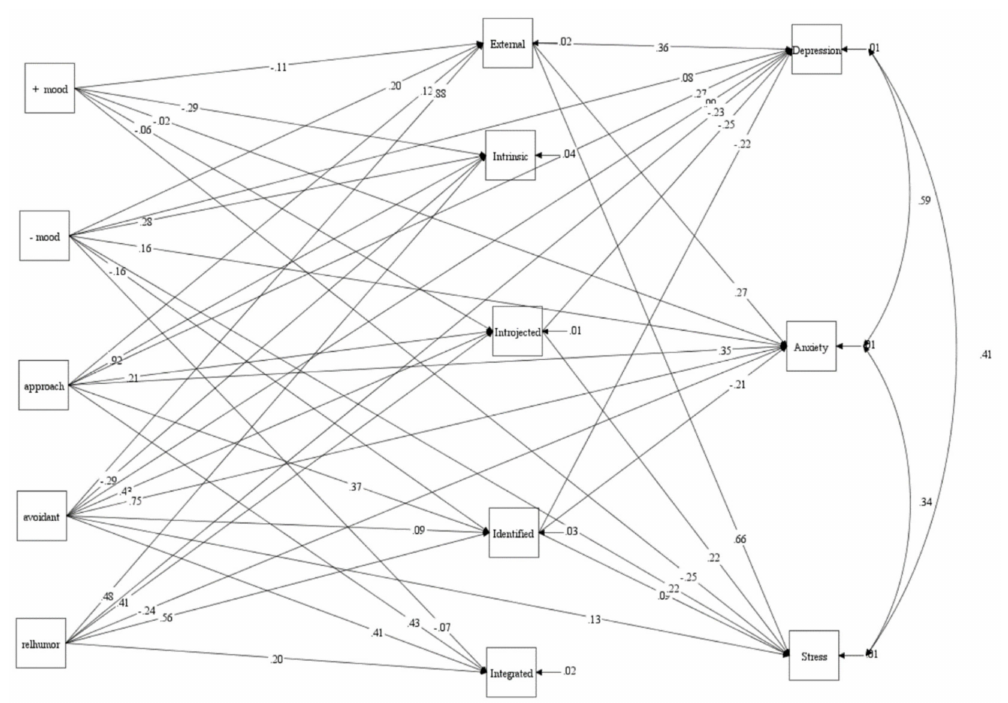
Figure 2. Path diagram of the final model (Model 5) with standardized regression weights. Note: +mood—positive mood, − mood—negative mood, relhumor—religion and